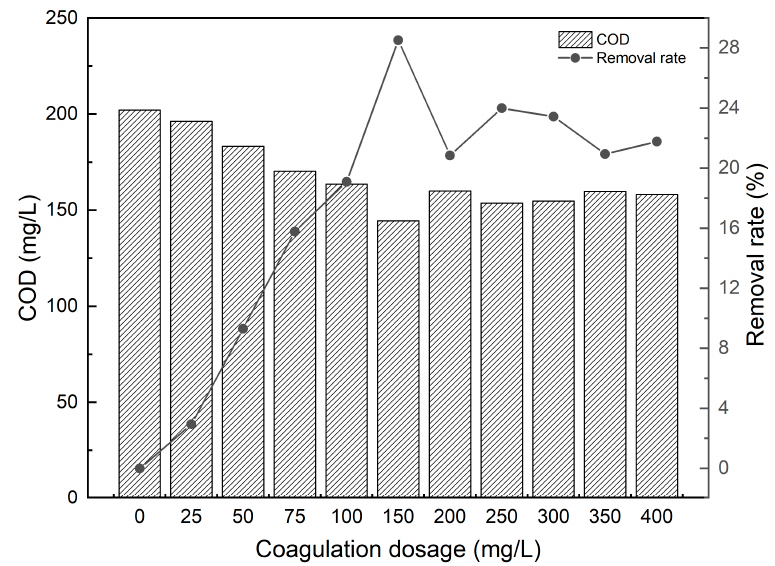
Figure 1. Variation in removal efficiency with polyaluminum chloride dosage.